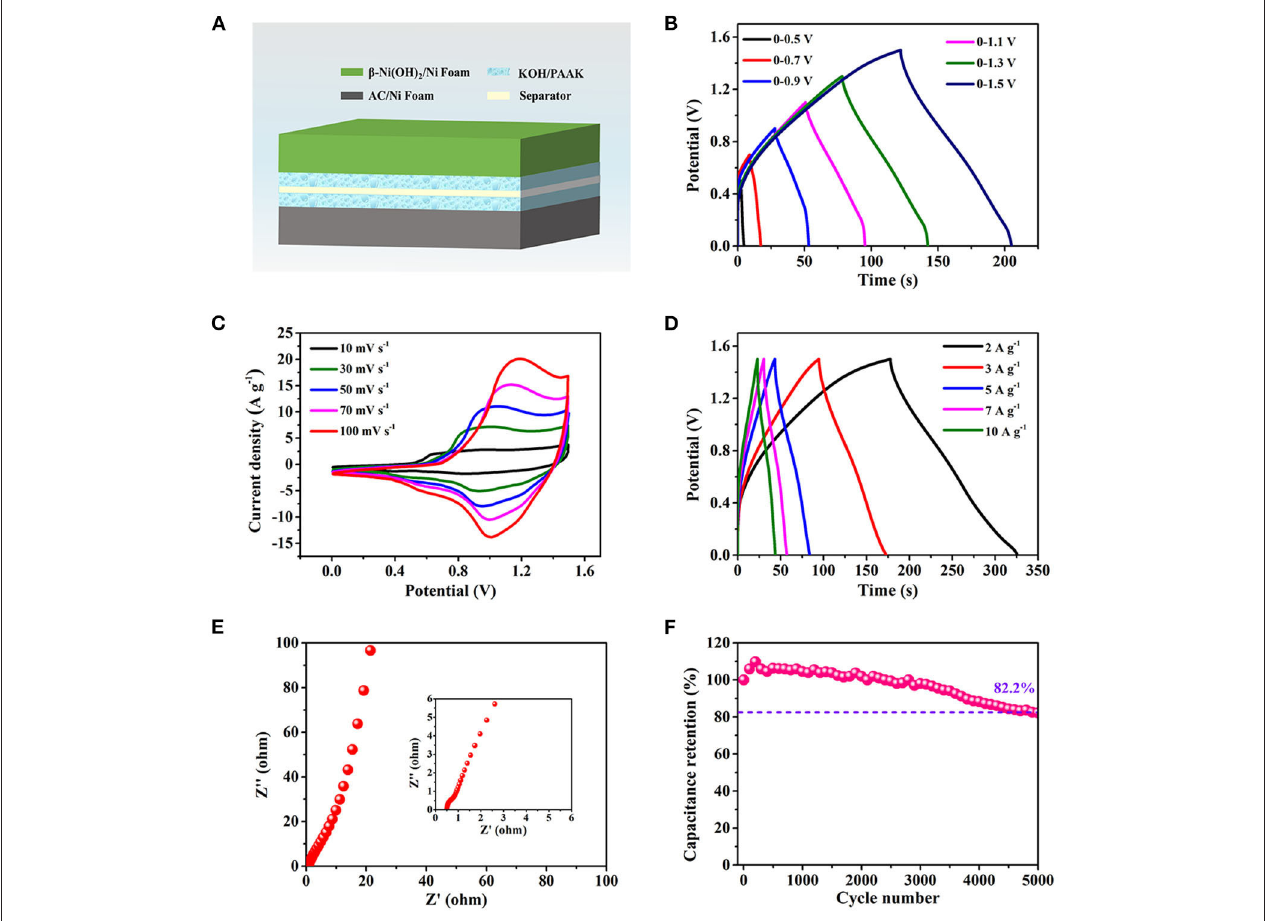
FIGURE 4 | The electrochemical performance of the asymmetric AFSC device. (A) Schematic of the assembled AFSC device. (B) GCD curves at various potential windows. (C) CV curves at different scan rates. (D) GCD curves at different current densities. (E) EIS result of the AFSC. (F) Capacitance retention after 5,000 cycling